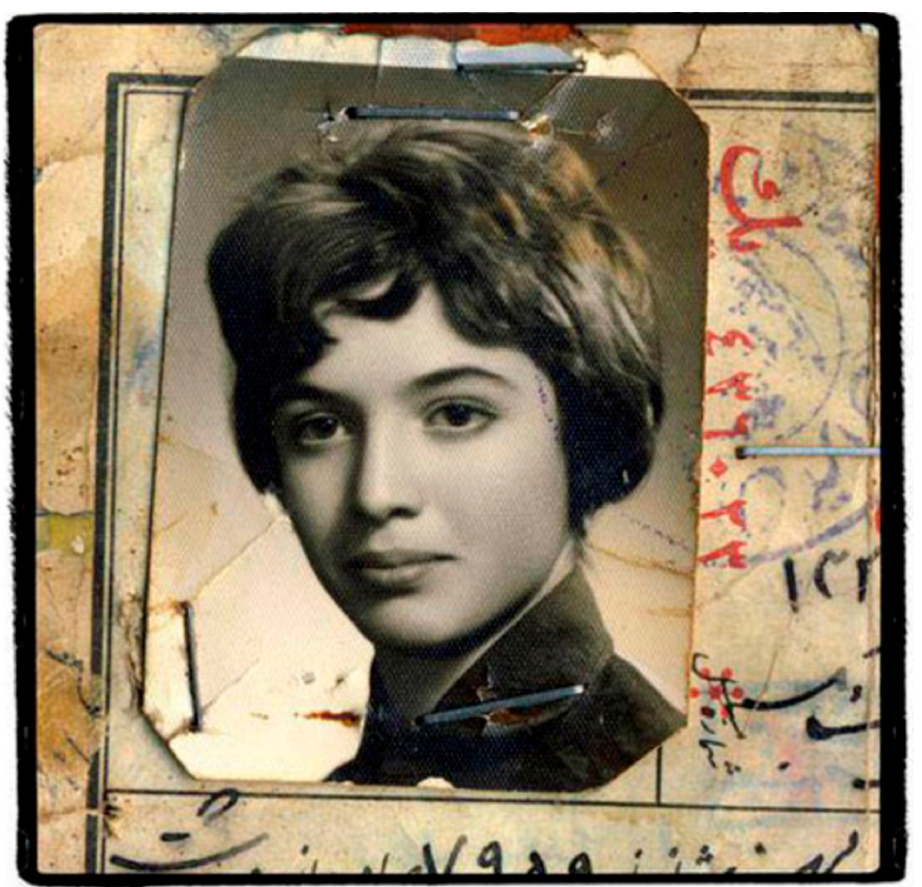
Figure 3. Najaf Shokri, from the Irandokht series, 2016, sonography, digital print on paper, 20 × 20